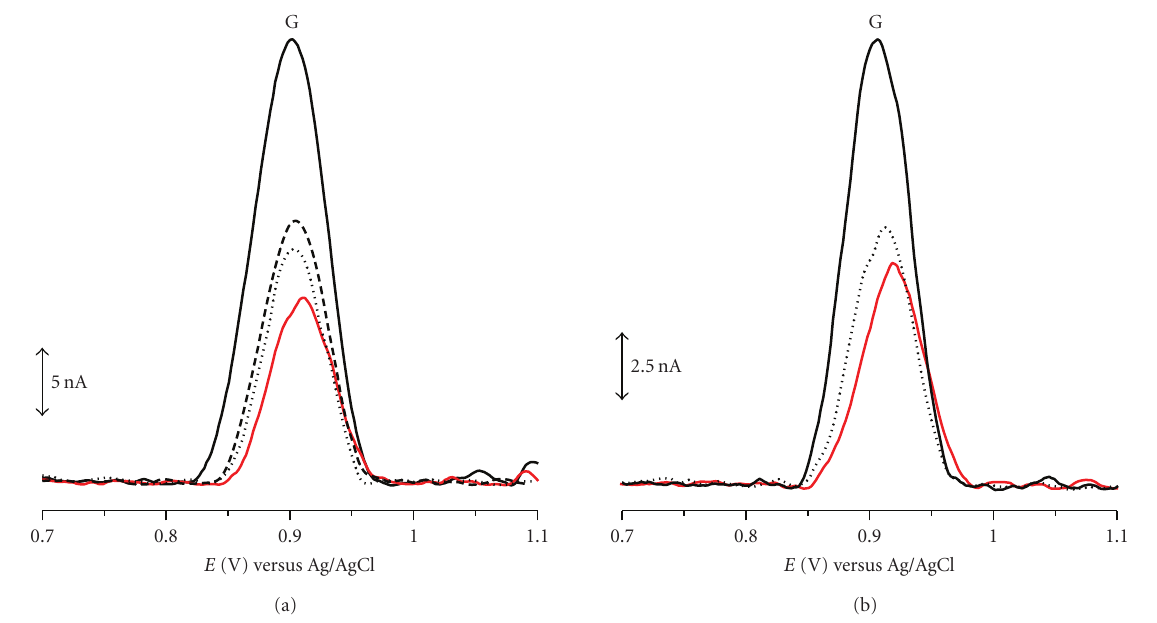
Figure 3: Baseline corrected DPV obtained with the GC electrode in a solution of 1 μ g mL − 1 TBA in pH 7.0 0.1 M phosphate bu ff er: (a) (solid line) in the absence and in the presence of 100 mM KCl after (dashed line) 0 hour, (dotted line) 1 hour and (red line) 24 hours of incubation and (b) in the presence of (solid line) 50, (dotted line) 100 and (red line) 200 mM KCl after 24 hours of